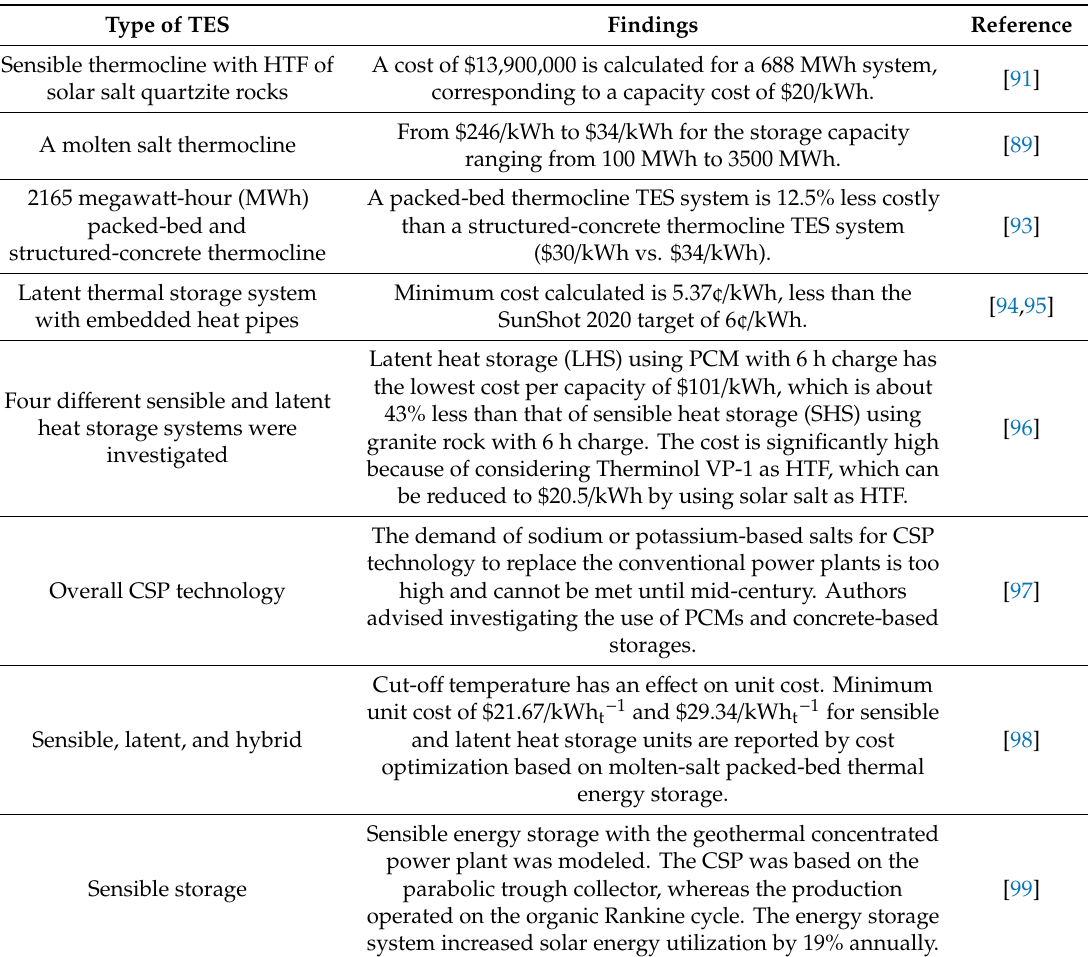
Table 6. Cost analysis of di ff erent pieces of research by incorporating thermal energy storage into concentrated solar power plant. Findings